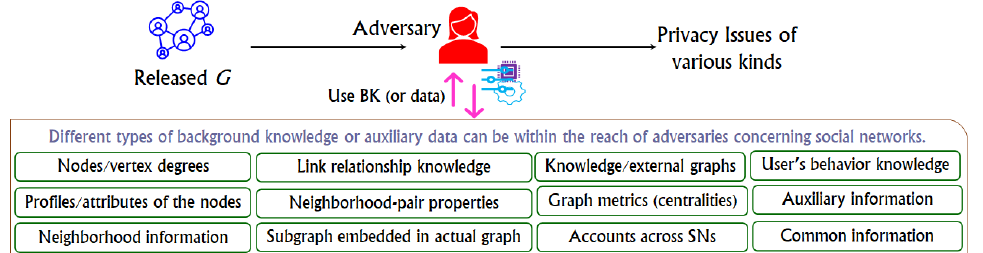
Figure 8. Types of BK employed by the adversaries to jeopardize users’ privacy in a released G